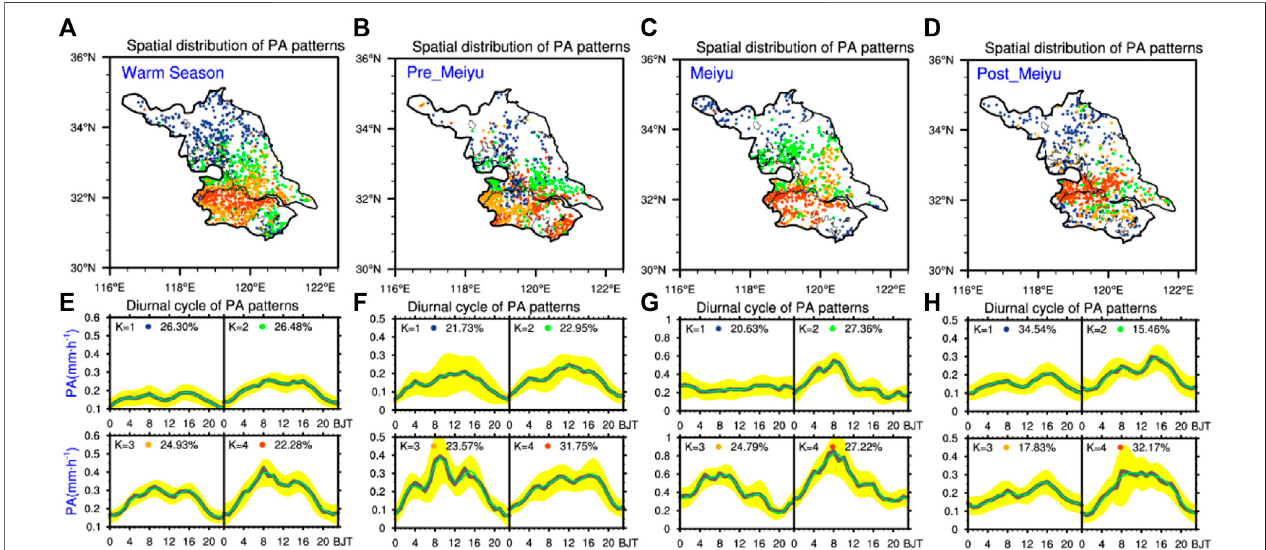
FIGURE12| SpatialdistributionsofPApatternsandtheircorrespondingdiurnalcyclesalongwiththestandarddeviationofthePAamongthestationsbelongingto a given cluster (shaded in yellow) in Jiangsu during different periods. The marks of PA patterns K (A-D) are labeled (E-H) . Percentage (E-H) indicates the ratio of the stationnumbersofeachPApatternKtothetotalstationswherethetotaldailyvarianceiswellexplainedbythe fi rstfourharmonics.Thegrey(green)lines (E-H) showthe diurnal cycles of PA with selected (all) stations.